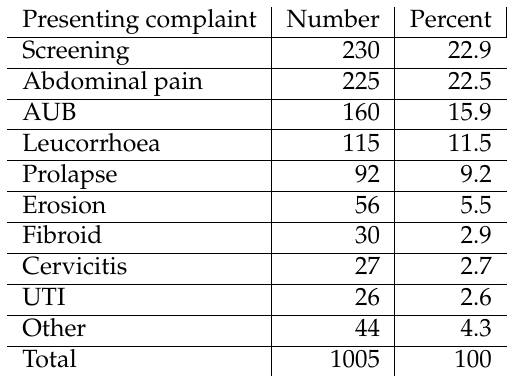
Table 2. frequency of distribution of various presenting complaint of women undergoing Pap smear